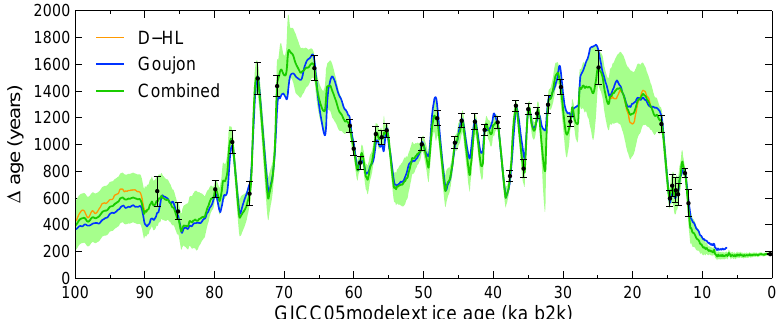
Fig. 8. Evolution of NEEM 1 age with timing constraints from CH 4 data (green curve and shaded area indicating the estimated uncertainty). Also shown are the results from the Goujon (blue) and dynamical Herron–Langway (orange) models and 1 age constraints derived from CH 4 data (black